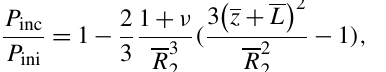
sure (0.6 GPa) is about 0.3–0.4 GPa, which may